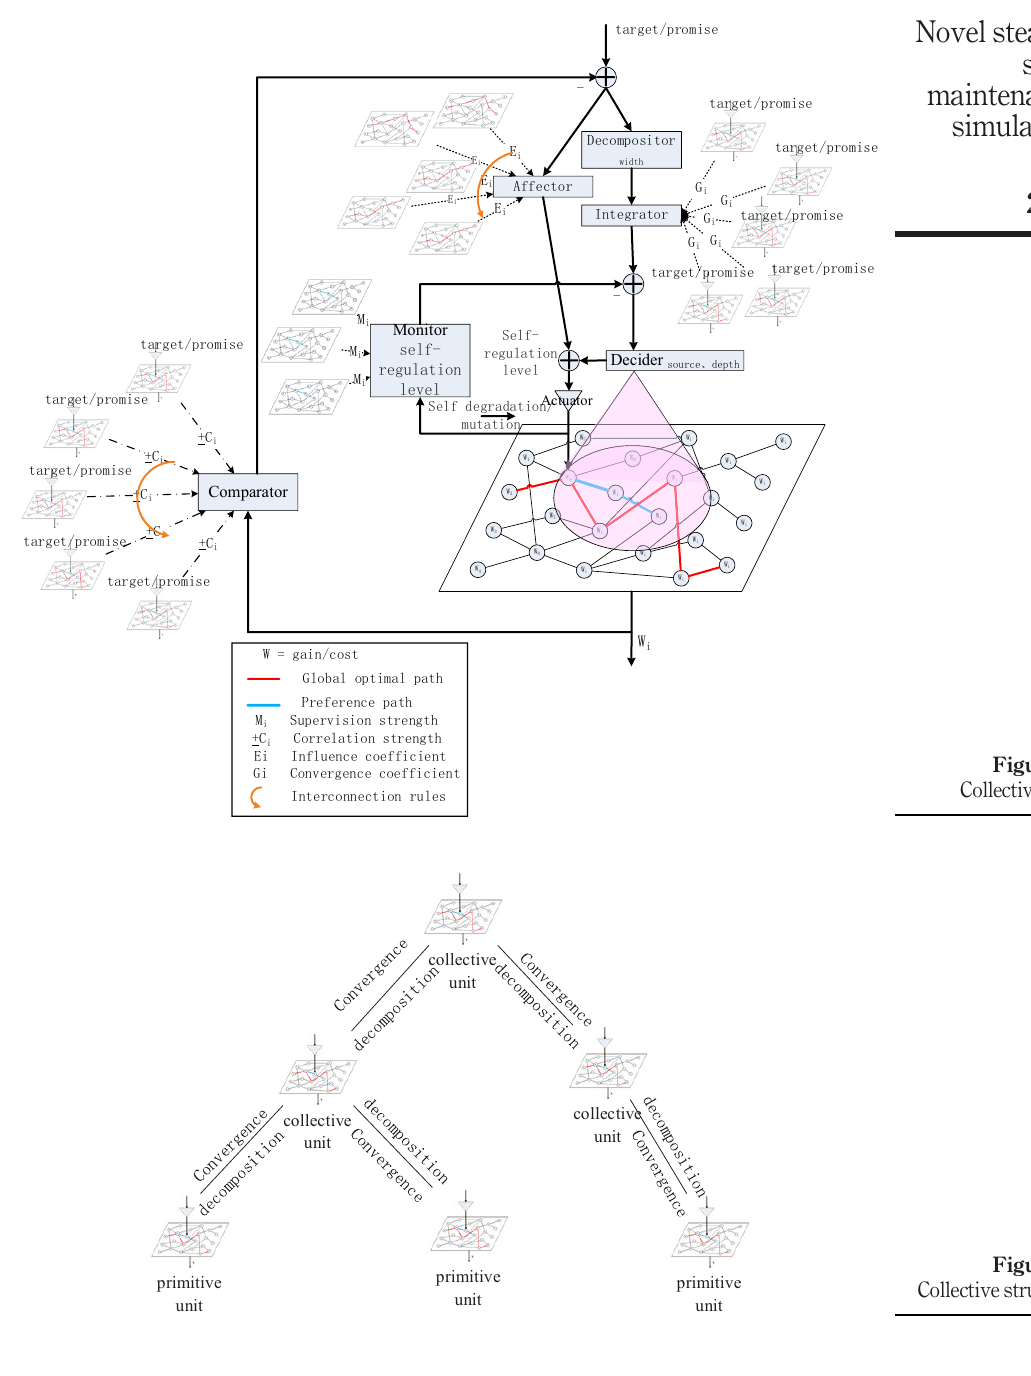
Figure 3. Collective structure